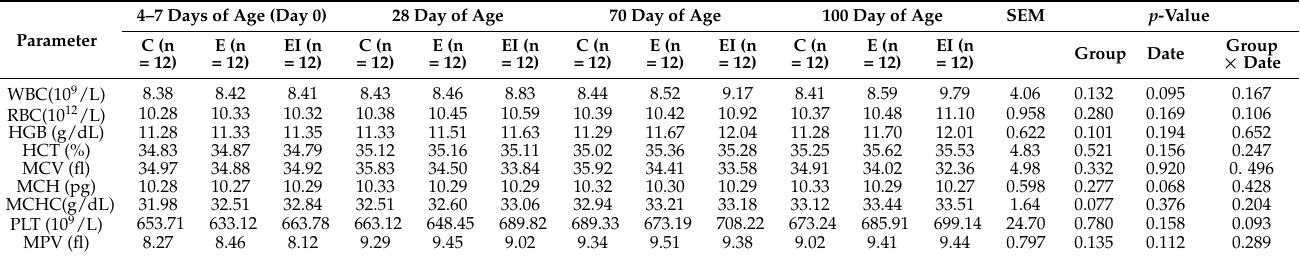
Table 3. Hematological parameters in lambs.